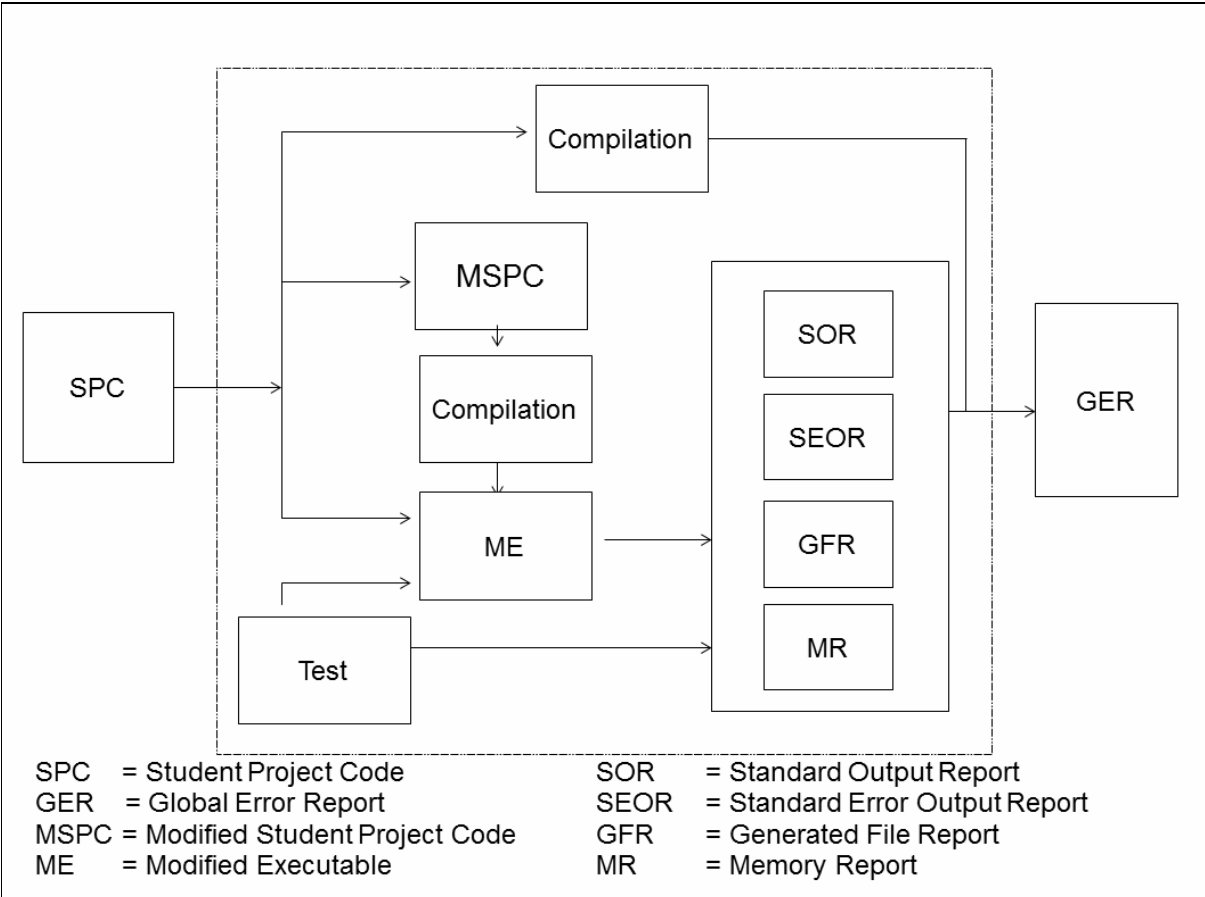
Figure 1. TVSP Functionality